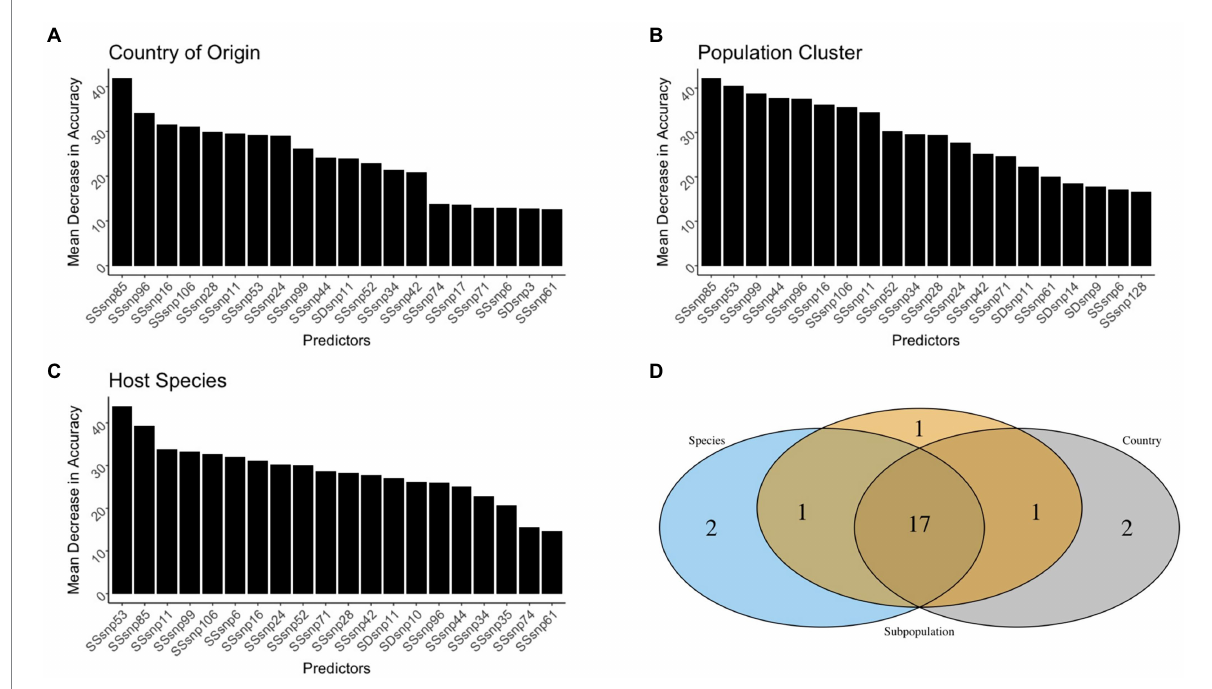
FIGURE 5 The top 20 predictors across the different scales. The predictors were presented for the Country of origin (A) , Population cluster (B) , and Host species (C) random forest models. A Venn diagram was used to identify predictive genomic regions that were shared and unique across models (D) .